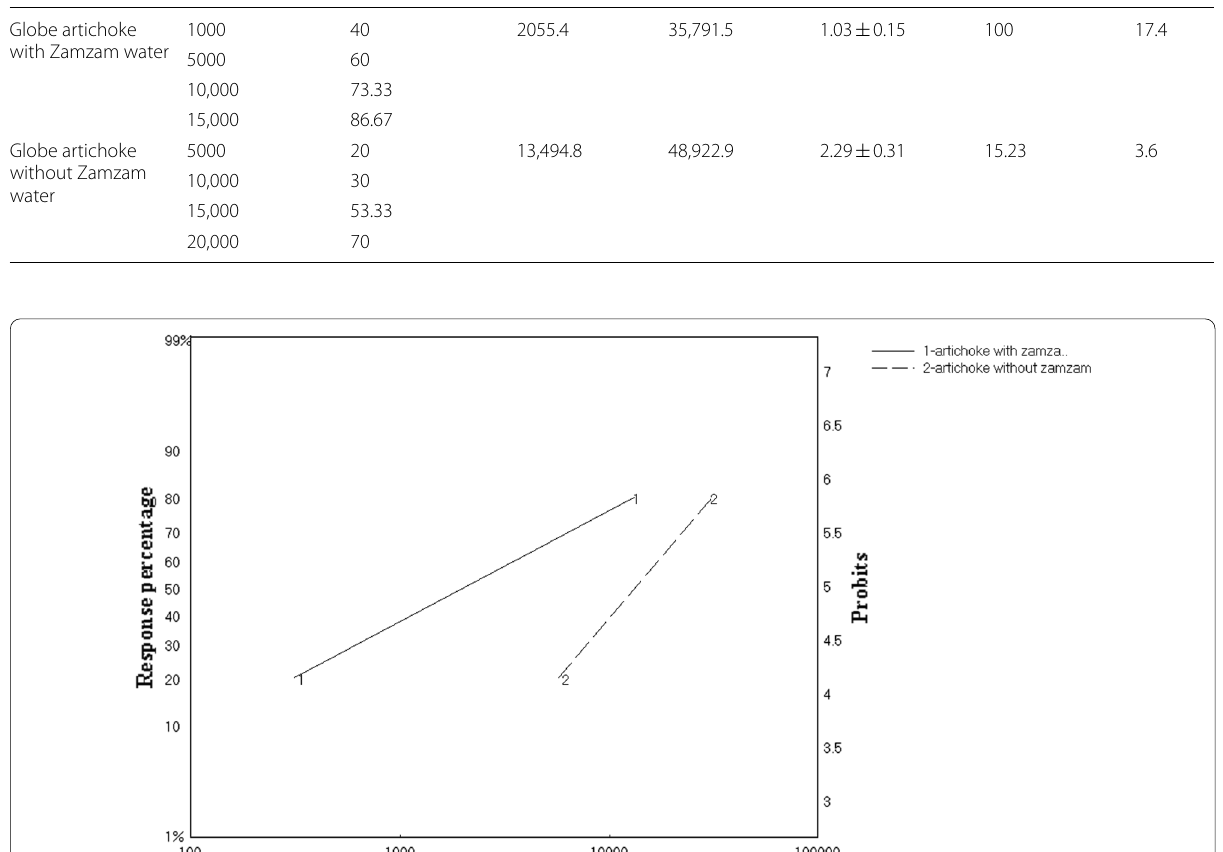
Fig. 2 LC‑P line for artichoke extract with and without Zamzam water of P. solenopsis